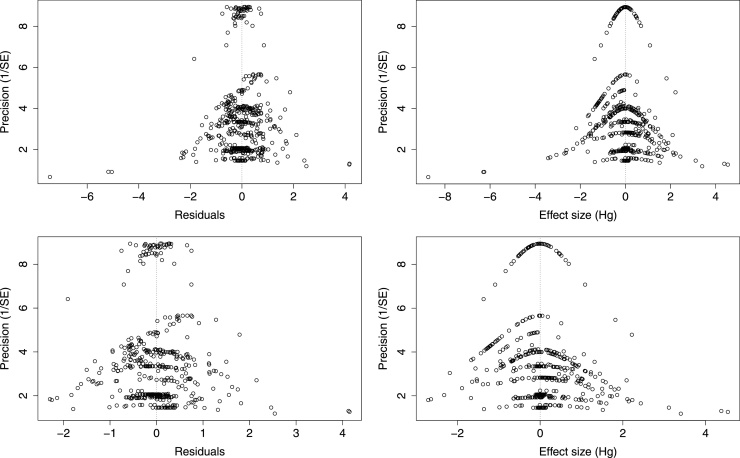
Funnel plots of (a) the meta-analytic residual values (residuals + sampling errors) for the full meta-regression model prior to exclusion of effect sizes from studies using adrenergic system targeting drugs; (b) the raw effect sizes and the inverse standard errors prior to exclusion of effect sizes from studies using adrenergic system targeting drugs; (c) the meta-analytic residual values for the full meta-regression model following exclusion of effect sizes from studies using adrenergic system targeting drugs; (d) the raw effect sizes and the inverse standard errors following exclusion of effect sizes from studies using adrenergic system targeting drugs.